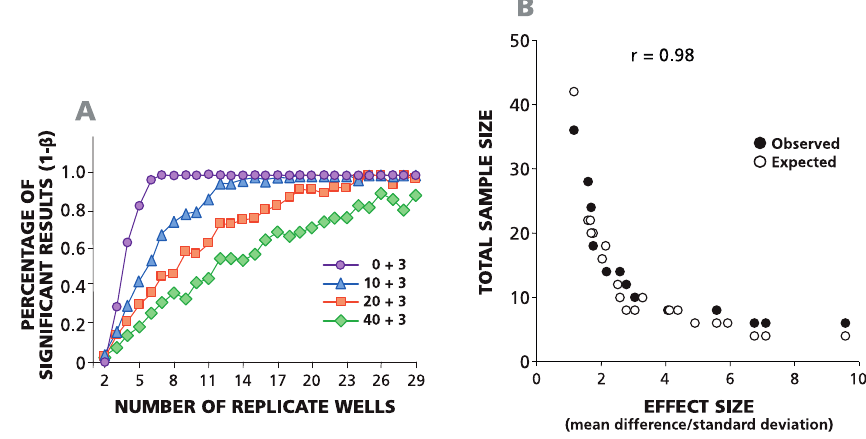
Figure 4. Observed and expected numbers of replicate wells required for detecting a statistically-significant difference between spot counts in positive and negative wells match closely. ( A ) The percentage of statistically-significant positive responses is plotted vs. the number of replicative wells for four different, artificially-created weak positive responses (zero background spots plus three spots, 10 plus three, 20 plus three and 40 plus three). The percentage of significant results was calculated for different numbers of replicate wells (from two to 29) generated using permutations of all 29 experimental replicate wells. ( B ) The theoretically-predicted (expected) and experimentally-observed numbers of replicates, necessary for a percentage of significant results over 90% in a two-tailed test, are plotted vs. the effect value ( δ / σ